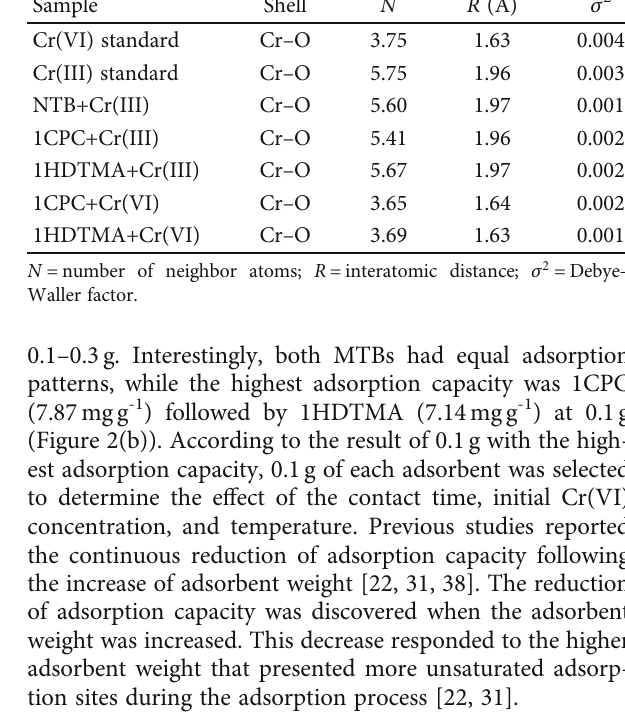
Table 3: Parameters of the isotherm adsorption analysis. Isotherm models